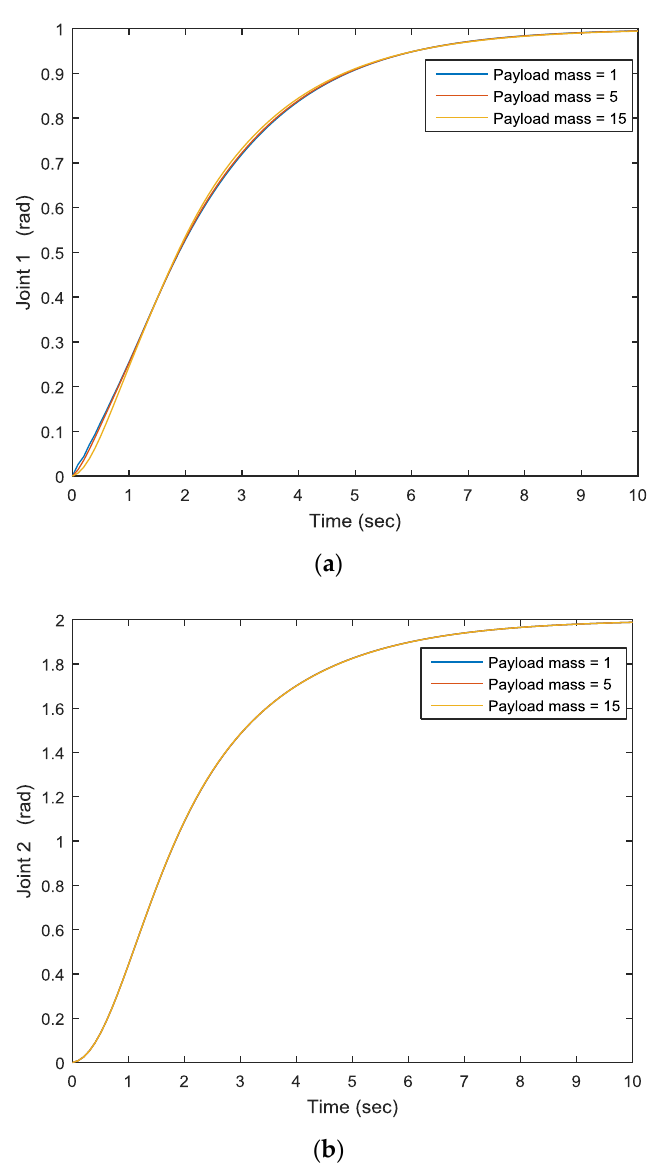
Figure 5. The output of joint 1 ( a ) and joint 2 ( b ).